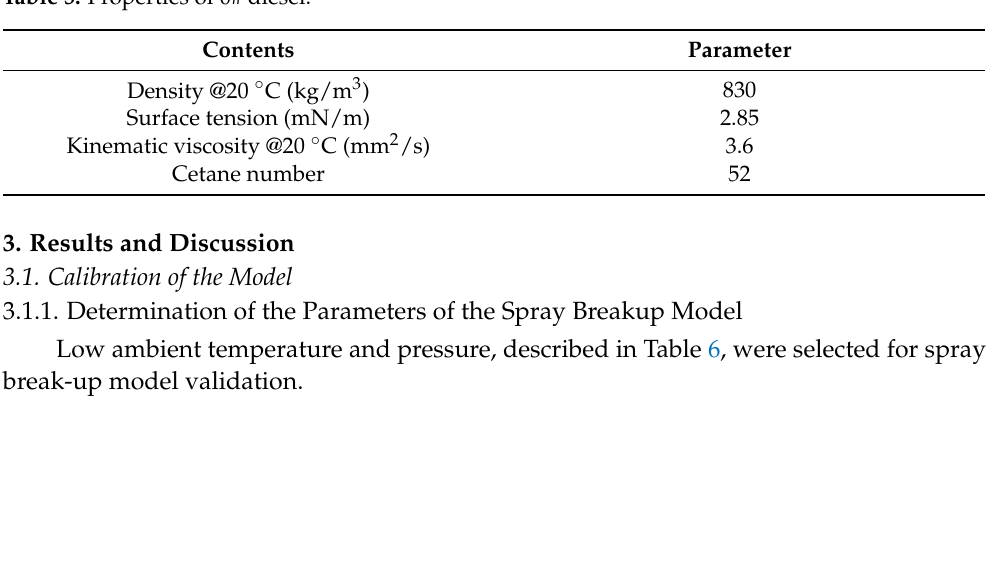
Table 5. Properties of 0# diesel.